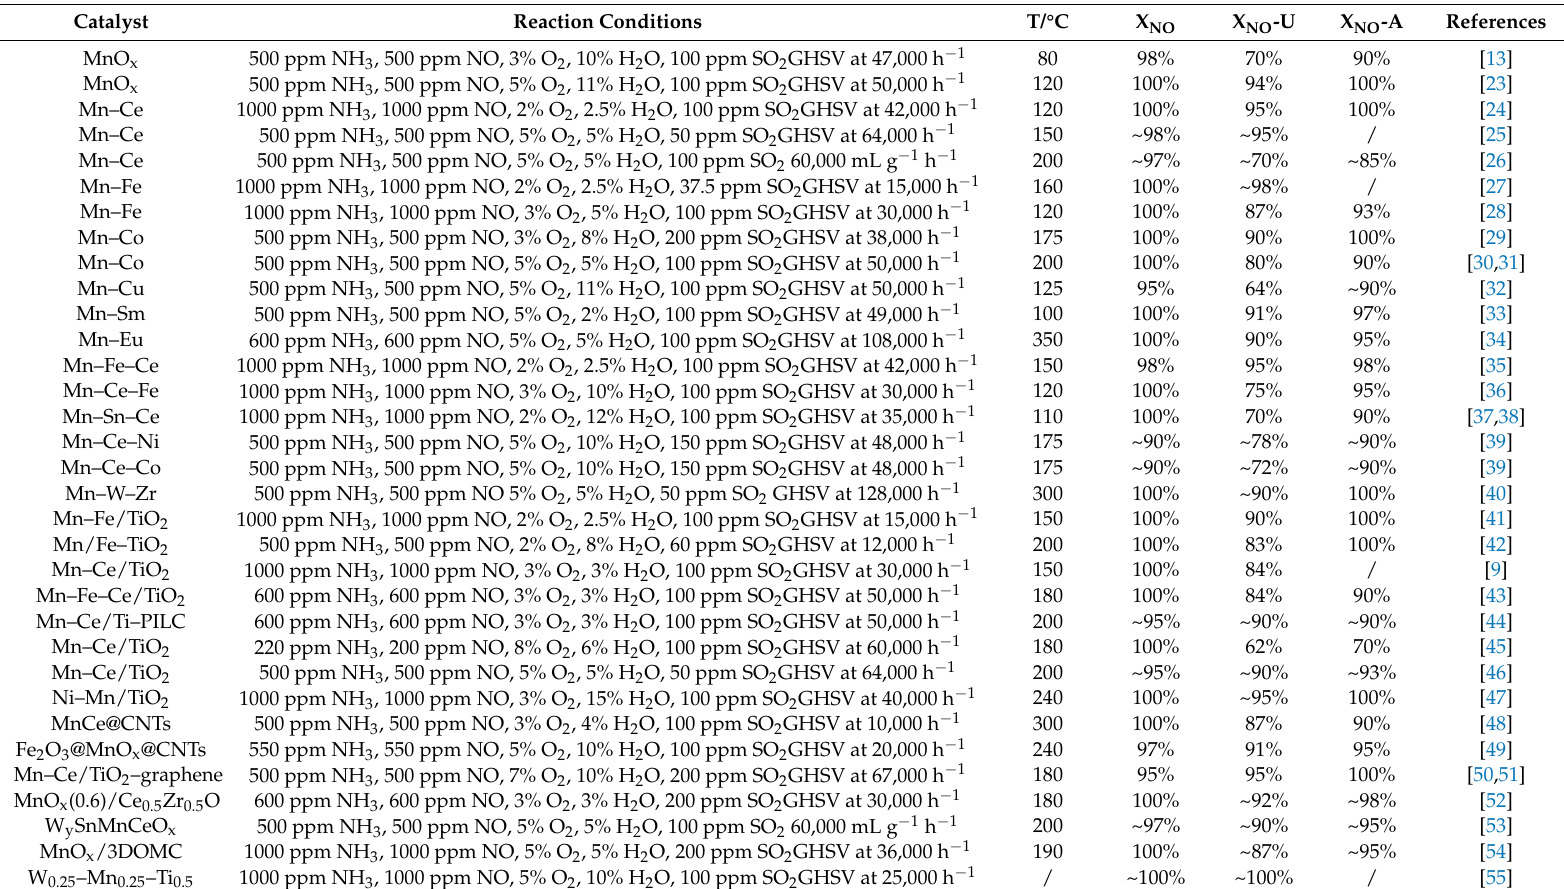
Table 1. Summary of the current status of H 2 O and SO 2 tolerance study on Mn-based catalysts in the literature. Catalyst Reaction Conditions T/°C X